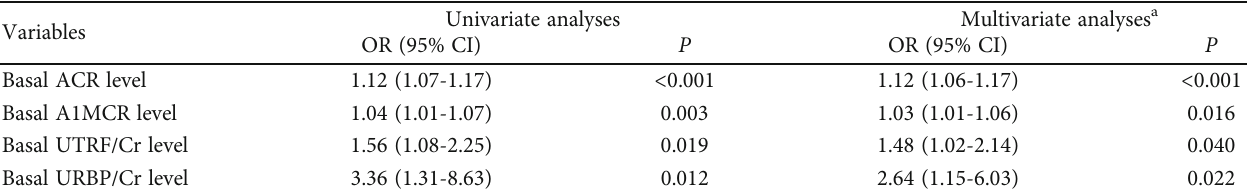
Table 2: The association of renal dysfunction development during the follow-up with the basal levels of the traditional renal biomarkers.